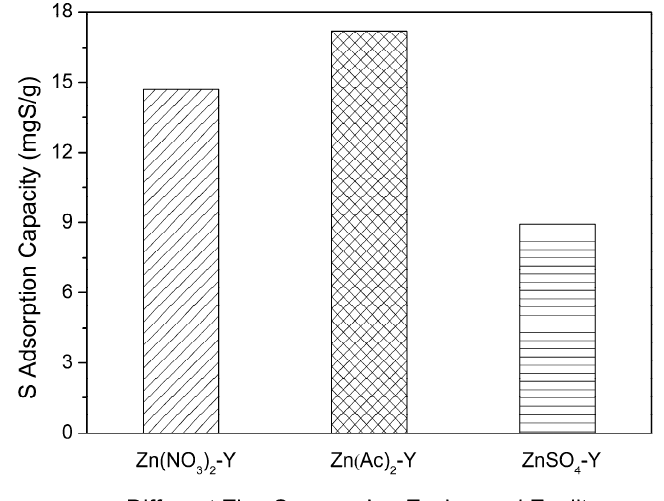
Figure 4. Effect of Zn sources on sulfur adsorption capacity (initial sulfur concentration: 1000 ppmw, T = 40 °C, t = 2 h, adsorbent dosage = 20 g/L; ion-exchange time: 10 h, ion-exchange temperature: 60 °C).